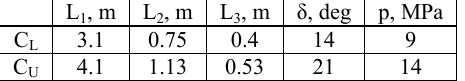
Table 6. Design variables bounds for Stage III